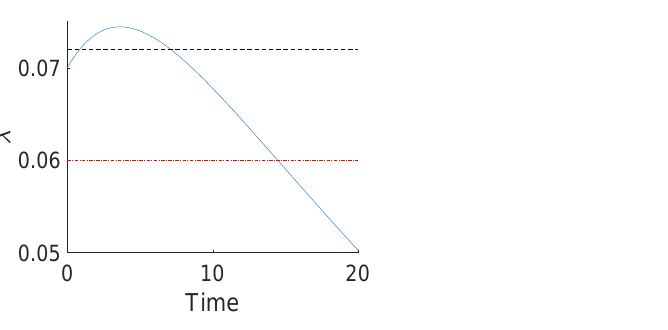
Figure 2. The figure shows the λ curve and the flat r flat curve. The black line corresponds to r = 0.072 and the red one to r =